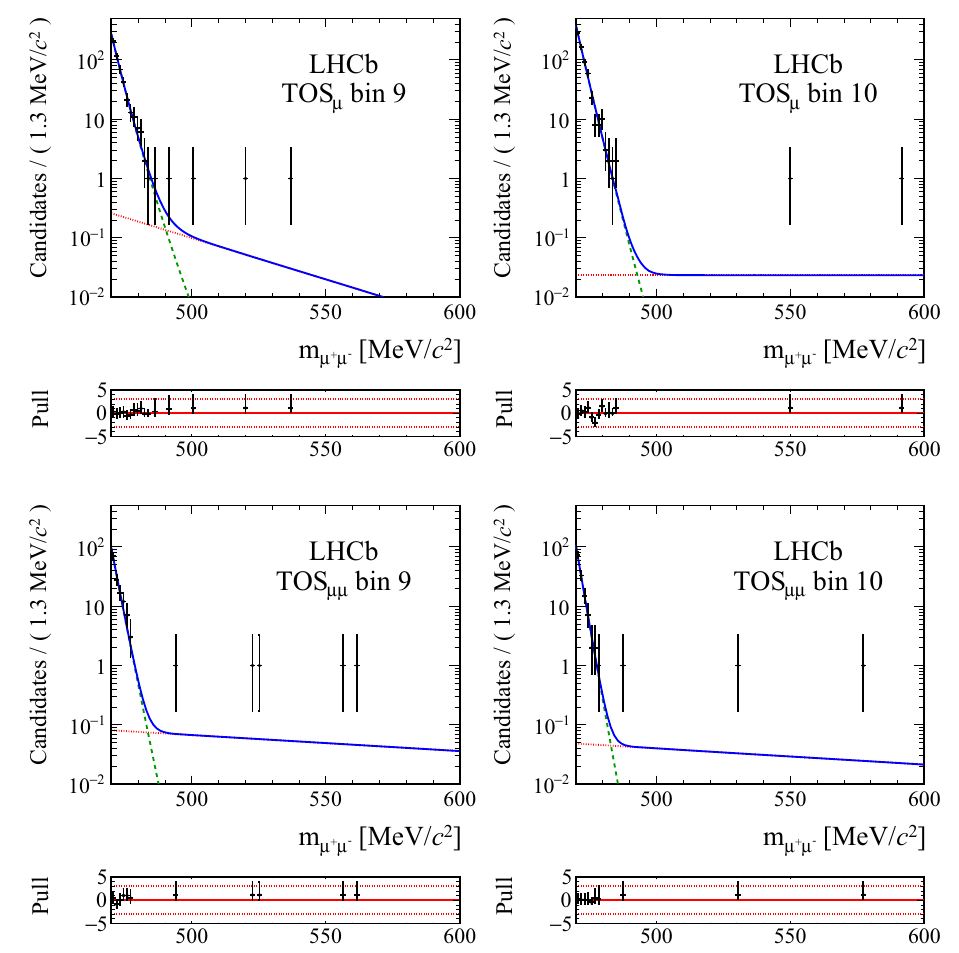
Fig. 2 Fits to the reconstructed kaon mass distributions, for the two most sensitive BDT cb bins in the two trigger categories, TOS μ and TOS μμ . The fitted model is shown as the solid blue line, while the com-